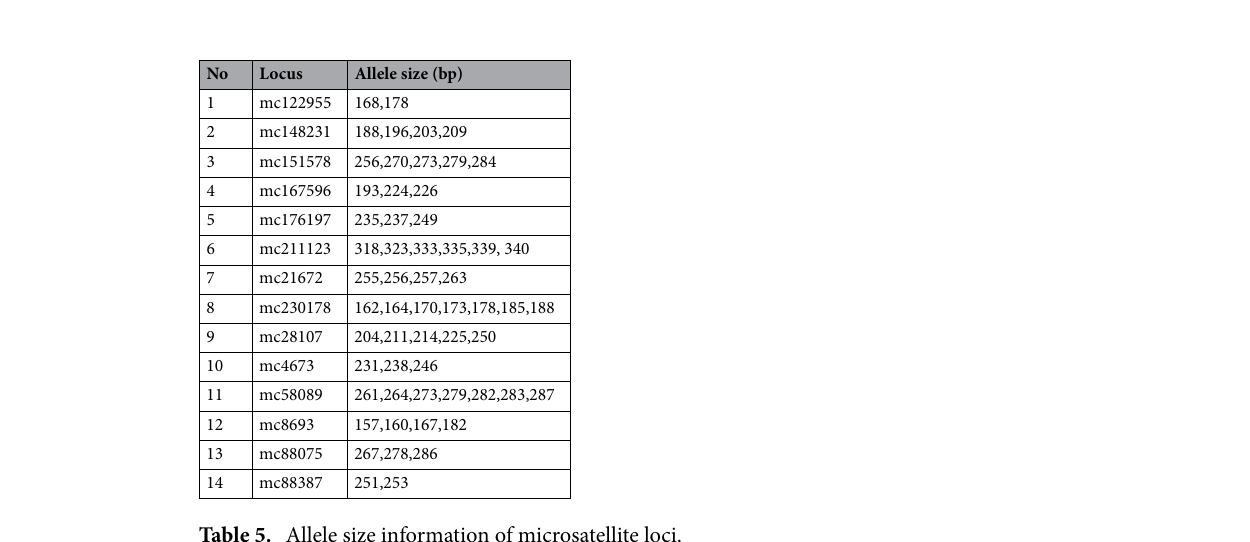
Table 5. Allele size information of microsatellite